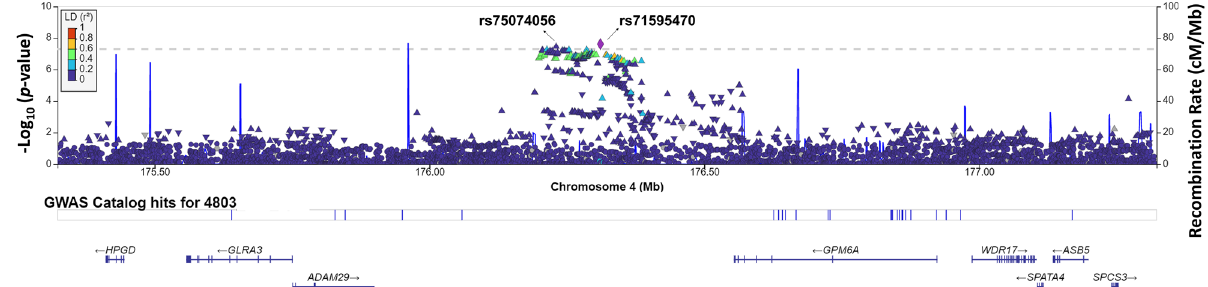
Figure 2. LocusZoom plot of the genomic region in the proximity to GPM6A associated with tinnitus. The graph shows the linkage disequilibrium in the region of rs71595470. Each dot is showing the p -value for the SNPs in this region. The color bar indicates the level of the linkage